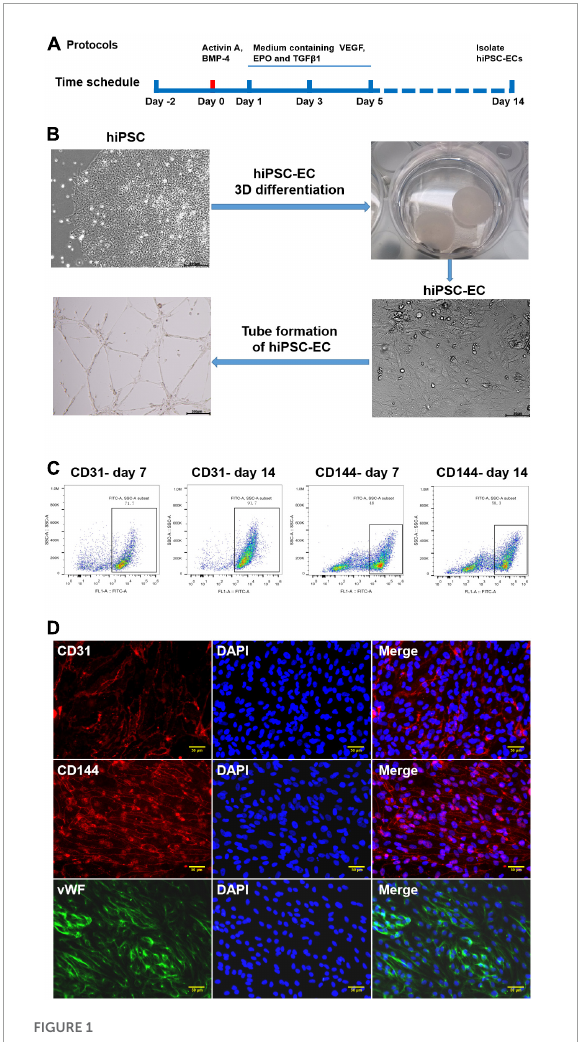
FIGURE1 Generation and characterization of human-induced pluripotent stem cell-endothelial cells (hiPSC-ECs). (A) Schematic representation of the protocol for differentiation of hiPSCs to ECs; (B) Differentiation of hiPSC-EC through a 3D protocol; (C) Flow cytometry assay for the detection of CD31 and CD144 expression post-hiPSC-EC differentiation; (D) Identification of hiPSC-EC by immunofluorescent